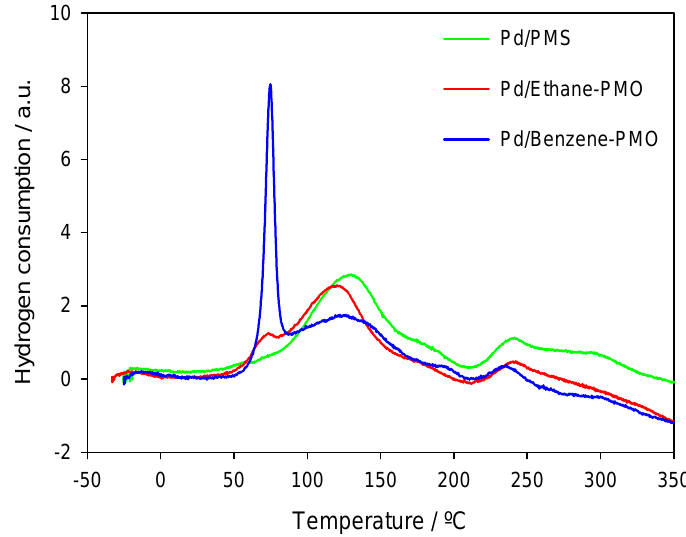
Figure 3. Temperature-programmed reduction (TPR) profiles for the different Pd-supported mesoporous